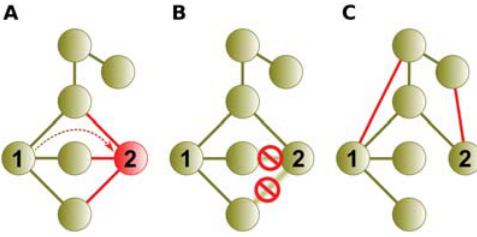
Figure 2. He and Zhang [ 6 ] illustrate the presence of neofunctionalization through interaction data analysis. (A) Paralogous proteins 1 and 2 initially share all 3 interacting partners. (B) In the absence of neofunctionalization, the number of interacting partners should remain at 3 as redundant interactions are lost over time. He and Zhang show that the number of interacting partners increases as the age of paralogs increases. (C) The increase in interacting partners is attributed to neofunctionalization (i.e., the de novo gain of interactions).